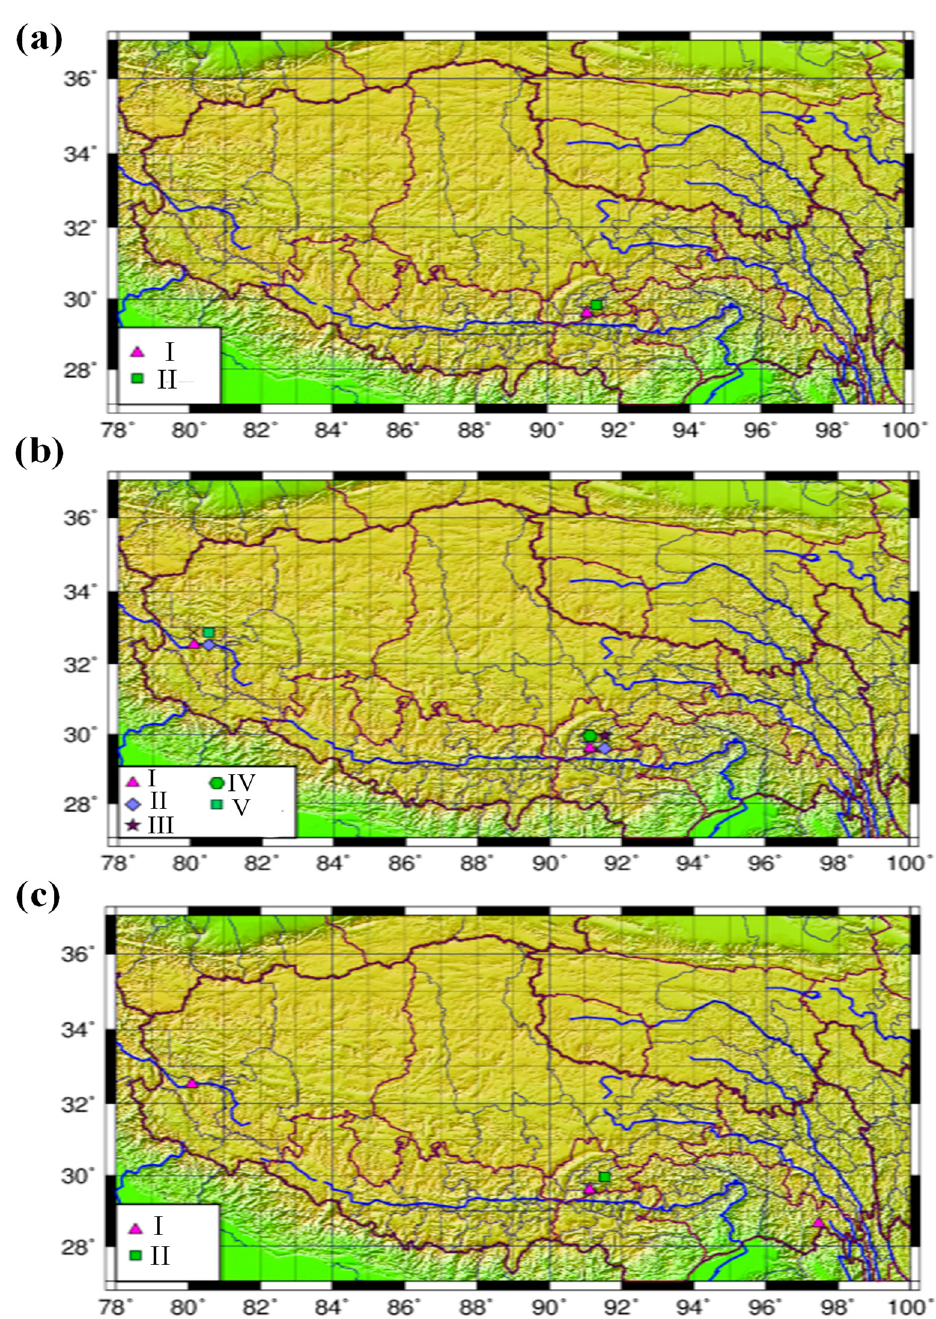
Figure 2. ( a ) Distribution of fluid measurement items in Tibet. I, water temperature; II, water level. ( b ) Distribution map of deformation measurement items: I, gravity; II, Vp; III, horizontal pendulum × vertical pendulum; IV, volumetric strain; and V, water meter. ( c ) Distribution map of electromagnetic measurement items: I, geomagnetism; II, geoelectricity. Table 1. Statistical table of stations/instruments composing the Tibetan Regional Seismic and Geo- physical Network.